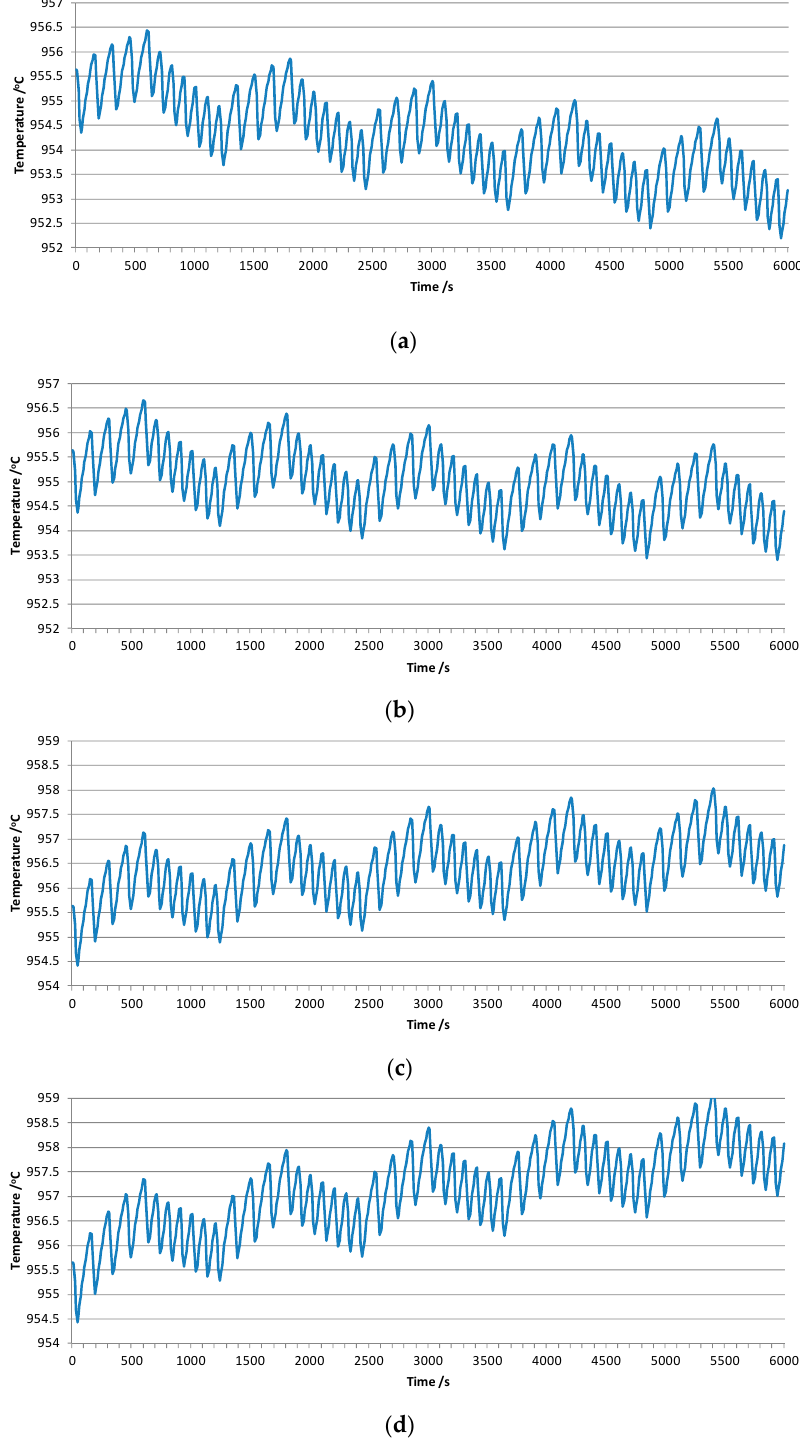
Figure 9. Temperature fluctuation curve under different ratios between P heat and P feeding . ( a ) Case 5 ( P heat / P feeding = 0.9); ( b ) Case 6 ( P heat / P feeding = 0.95); ( c ) Case 7 ( P heat / P feeding = 1.05); ( d )Case 8 ( P heat / P feeding = 1.1).